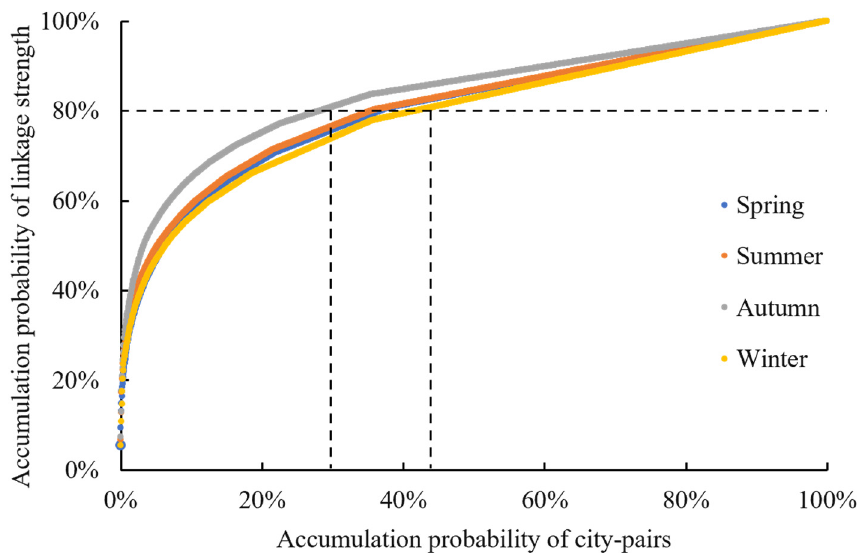
Figure 4. Comparison of the accumulation probability of the linkage strength between city-pairs.